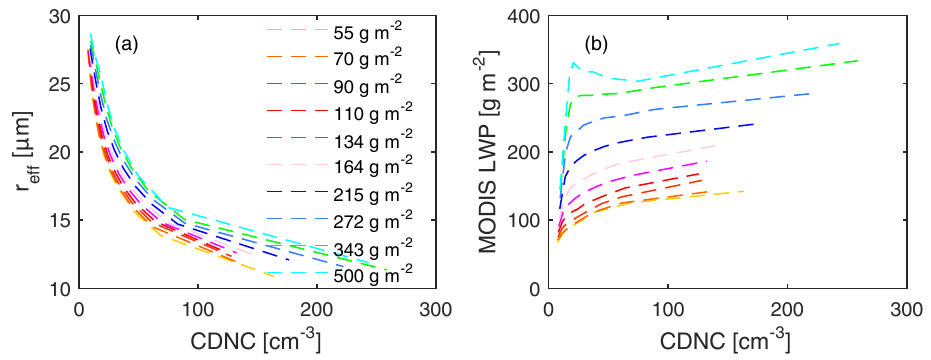
Figure 8. (a) r eff and (b) MODIS LWP as a function of CDNC for each AMSR-E LWP bin. Only rainy samples defined by a − 15dBZ threshold are used in here. Different color lines represent different AMSR-E bins corresponding to Fig. 7f.